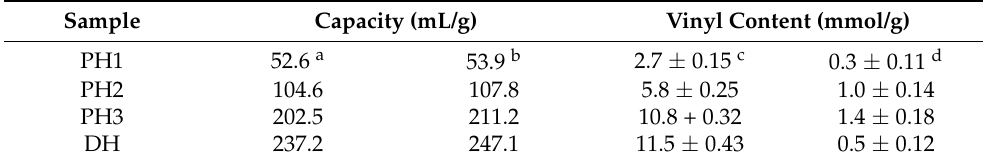
Table 1. (a) Getter capacity determined by both a pressure drop test and (b) chemical titration. (c) Vinyl content of each sample before and (d) after H 2 absorption.